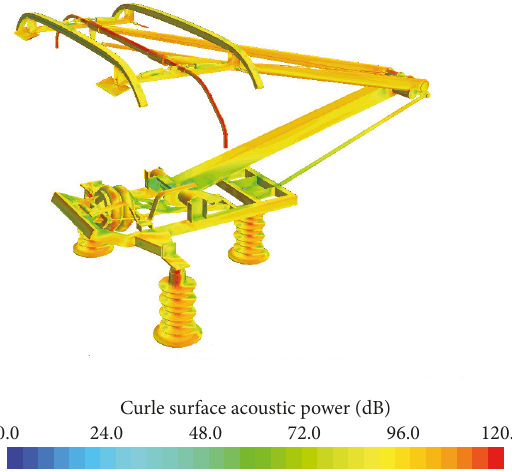
Figure 10: Distribution of dipole noise sources.